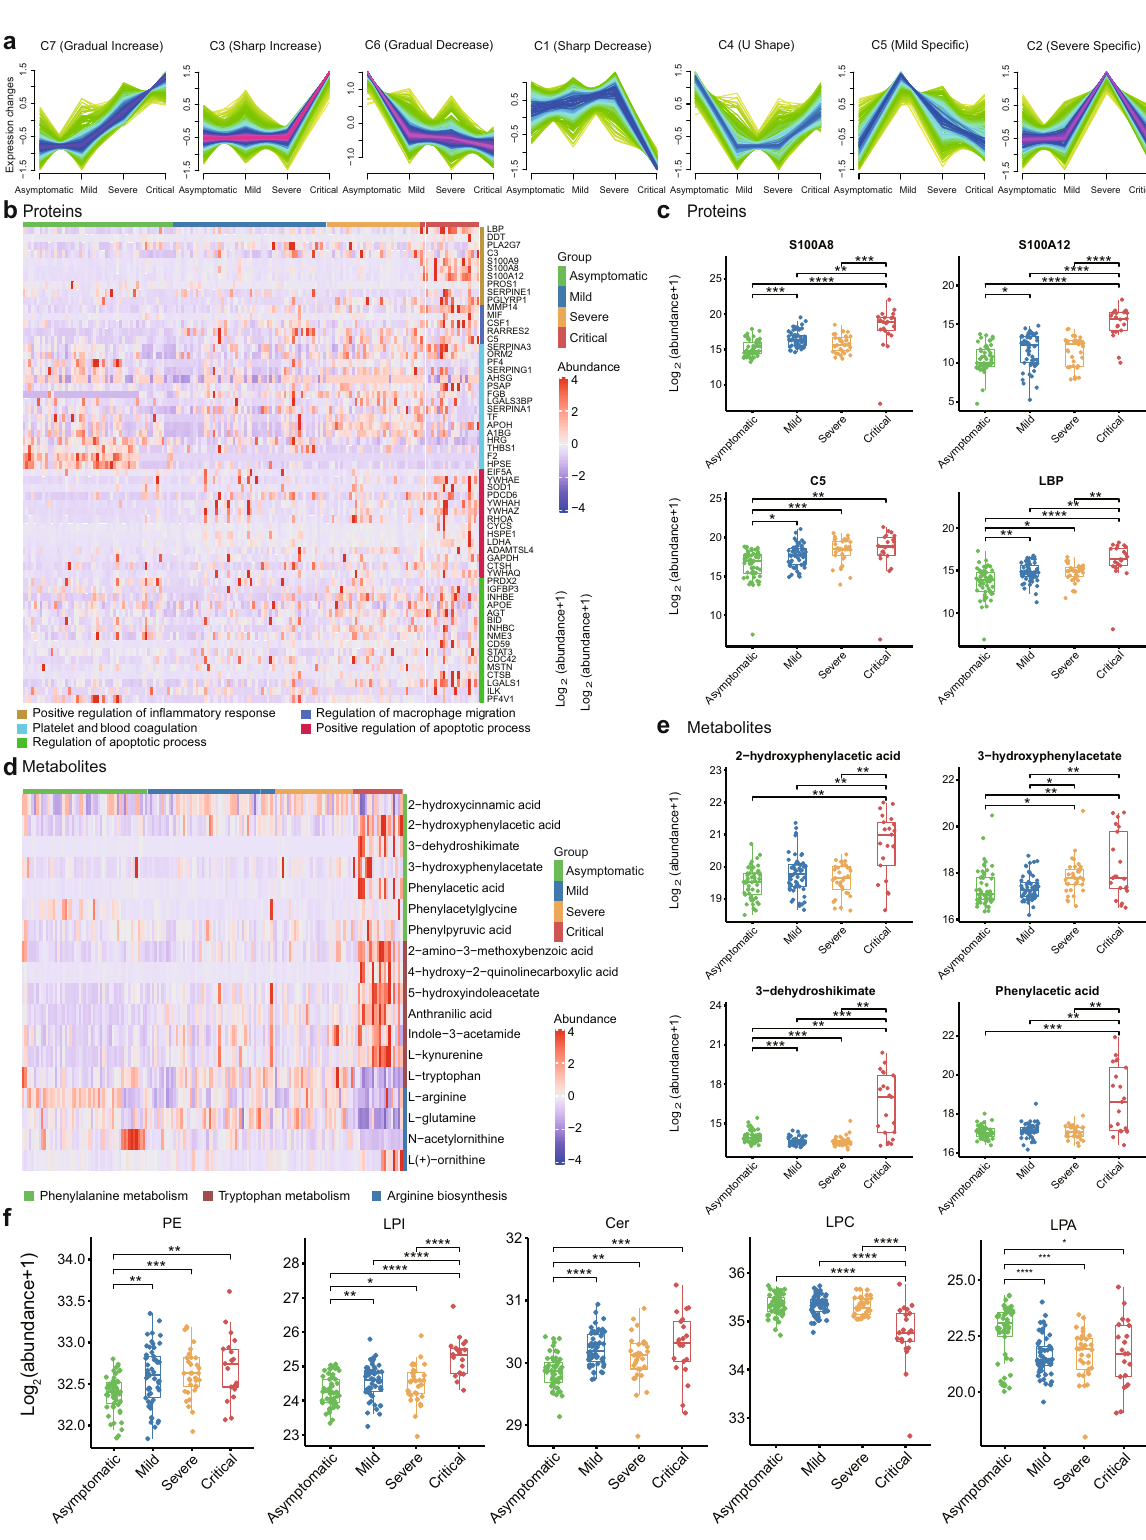
Tryptophan and arginine metabolism perturbations, and T cell regulated by RNA-binding proteins (RBPs) and microRNAs. dysfunction in critically ill COVID-19 patients . T cells play a Interestingly, RBPs (HNRNPD, ZFP36, ZC3H12A, ILF3, critical role in antiviral immunity against SARS-CoV-2 49 , but their ZNF692, FXR1, ELAVL1, and BRF1/2) and microRNAs ( miR- 181a-5p , miR-181a-2-3p , miR-10a-5p , miR-23b-3p ), which might functional state and contribution to COVID-19 severity remain involved in the degradation and destabilization of in fl ammatory largely unknown. In critically ill patients, the T/NK cell-mediated cytokines 45 – 48 , were highly expressed in asymptomatic patients adaptive immune response was defective (Fig. 2a, b). Interestingly, but lowly expressed in critical patients (Fig. 4g, h). Trp metabolism gradually increased with disease severity (Fig. 5a). NATURE COMMUNICATIONS| (2021) 12:4543